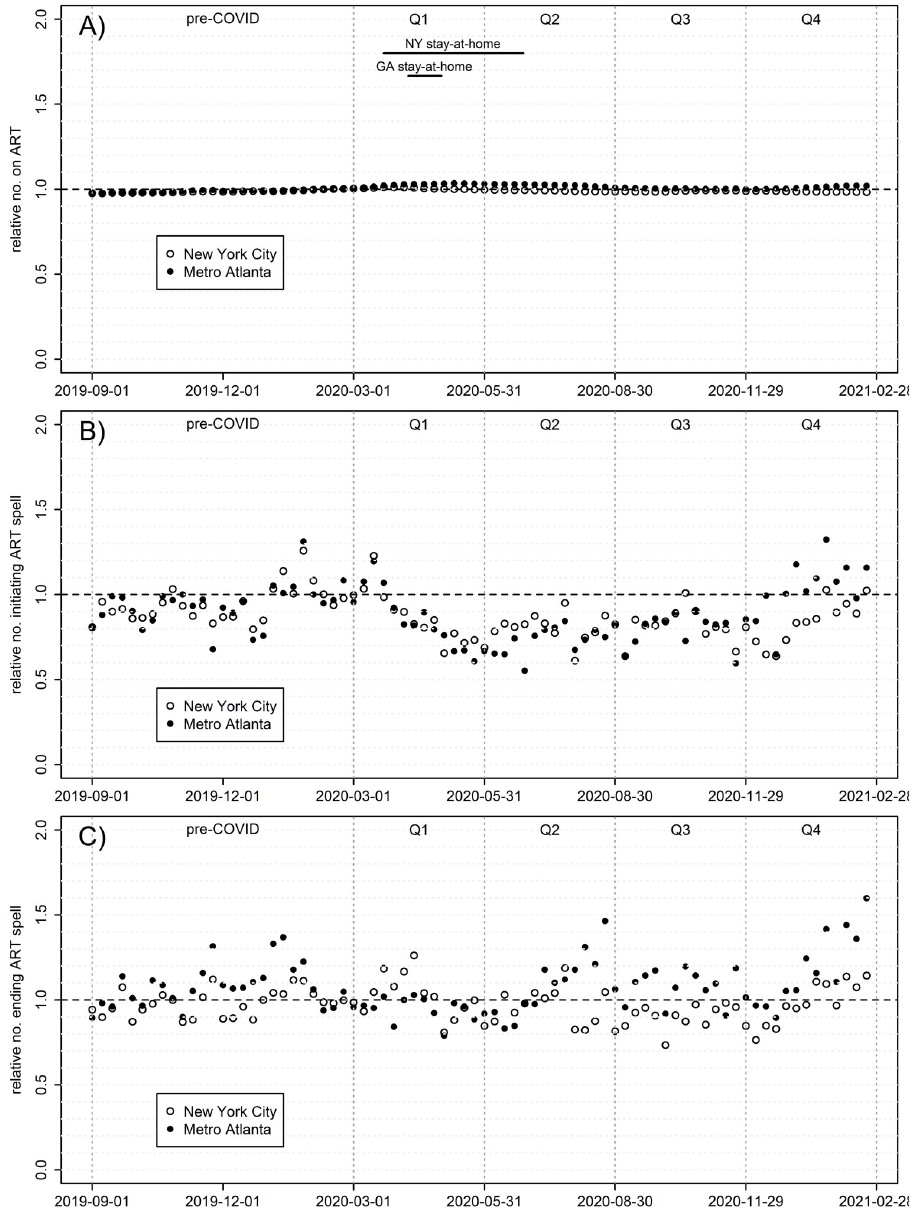
Fig 4. ART prescriptions among males, by week, rel. to weekly mean Feb. 2-Feb. 29, 2020. (A) Relative prevalence of ongoing prescription spells; (B) relative number initiating a new prescription spell; (C) relative number terminating a prescription